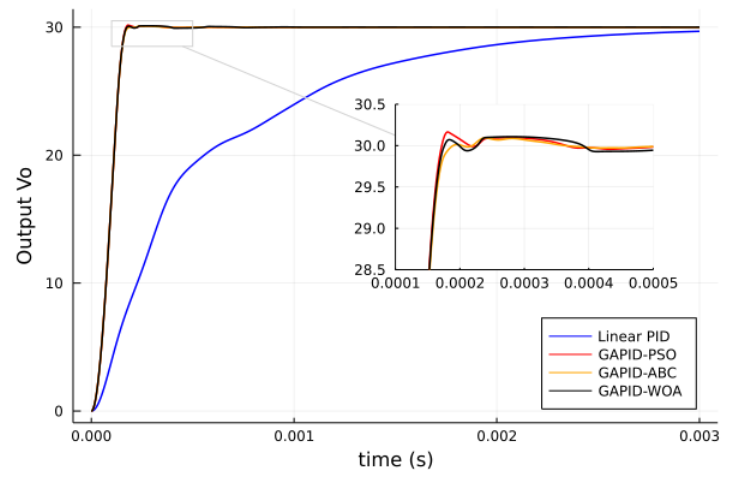
Figure 11. The converter output voltage V o for each control strategy.